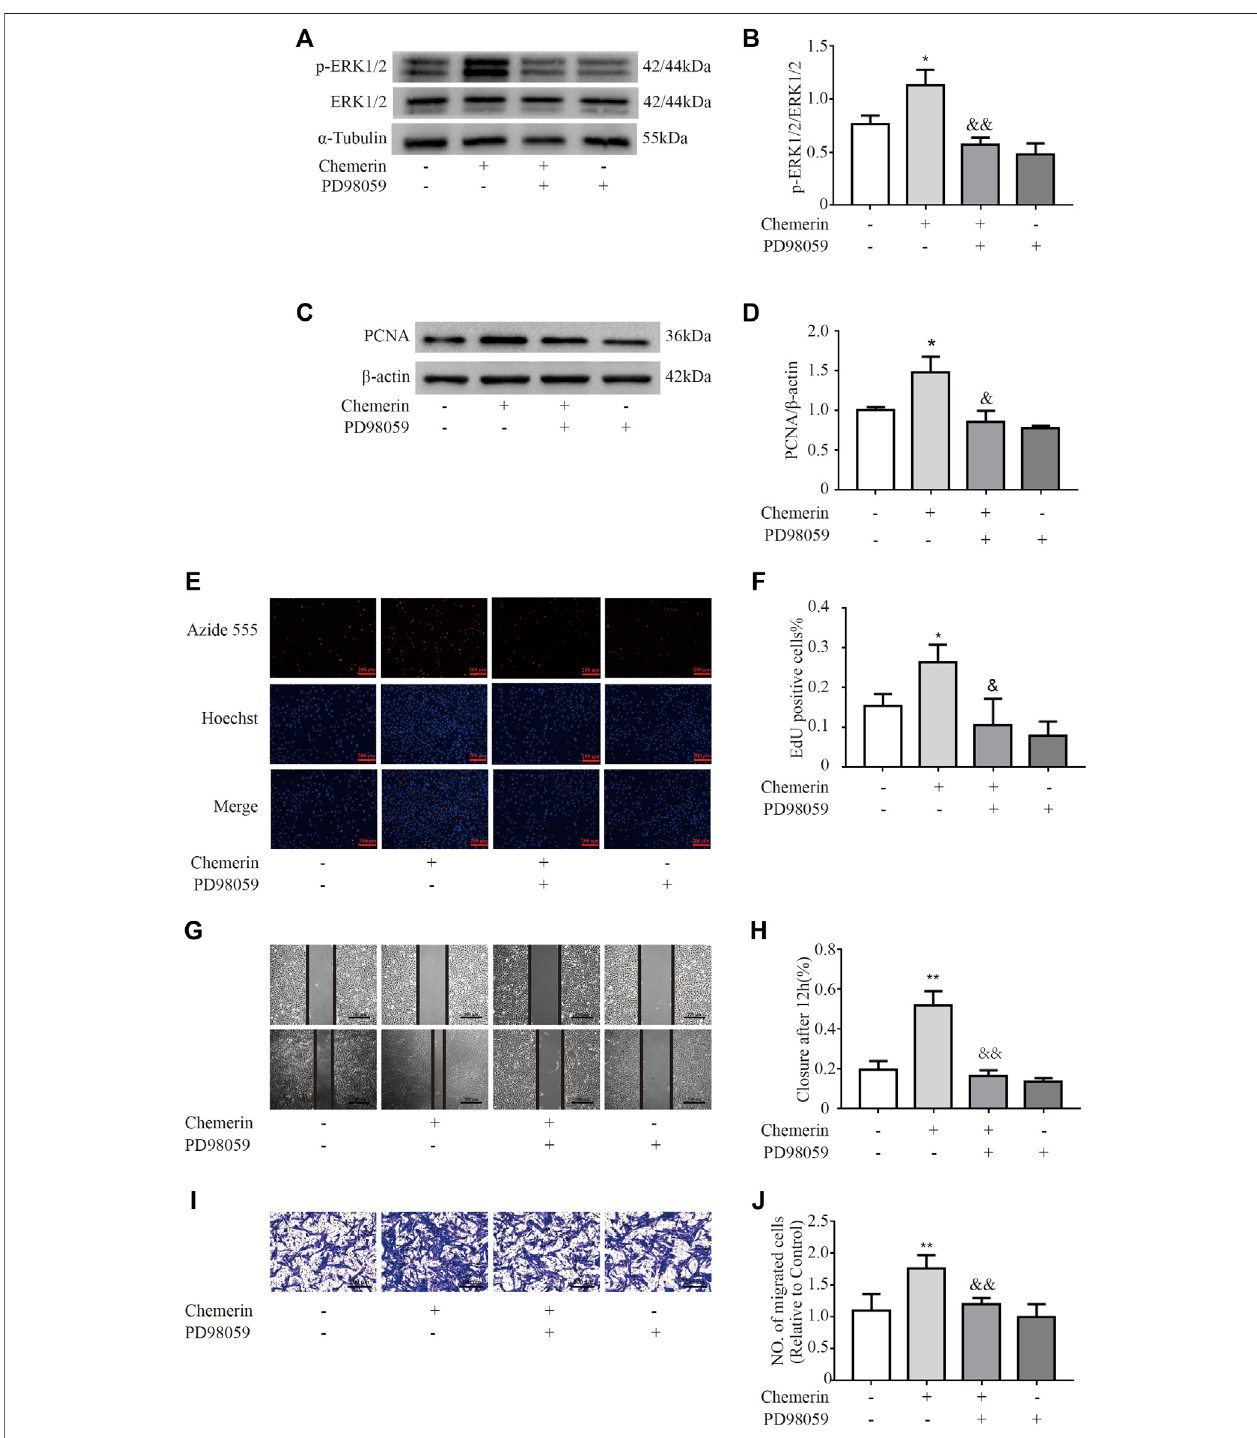
FIGURE6| ChemerininducesphenotypicchangesinPASMCs via theERK1/2signalingpathway.PASMCswerepretreatedwithPD98059(50 µM)30 minpriorto chemerin treatment (300 ng/ml). (A and B) Western blot analysis of p-ERK1/2 and ERK1/2 expression in PASMCs after stimulation by chemerin with or without PD98059 pretreatment for 12 h. (C and D) Western blot analysis of PCNA expression in chemerin-treated cells with or without PD98059 pretreatment for 24 h. (E and F) PASMCcellproliferationwasmeasuredbyanEdUstainingassayafter24 hoftreatment(originalmagni fi cation,×100,scalebars,200 μ m). (GandH) Imagesof scratches in PASMCs photographed at 0 and 12 h under different treatment conditions (original magni fi cation, × 50, scale bars, 500 μ m). (I and J) Transwell migration assays of PASMCs after different treatments for 12 h (original magni fi cation, ×100, scale bars, 200 μ m). * p ＜ 0.05 vs. the control group; ** p ＜ 0.01 vs. the control group; & p ＜ 0.05 vs . the chemerin group. && p ＜ 0.01 vs. the chemerin group.